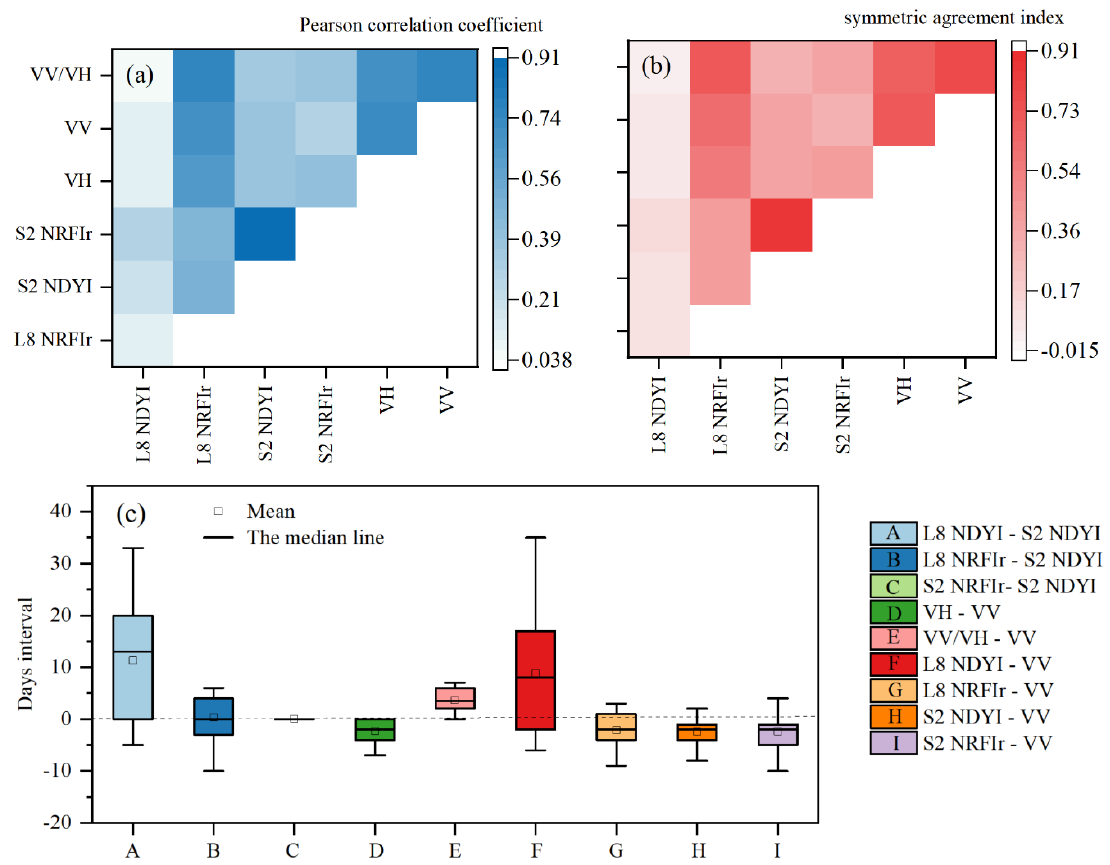
Figure 8. ( a ) Pearson correlation coefficients; ( b ) symmetry consistency indexes; ( c ) flowering intervals observed from different DWD stations and obtained from the combination of two different indexes.